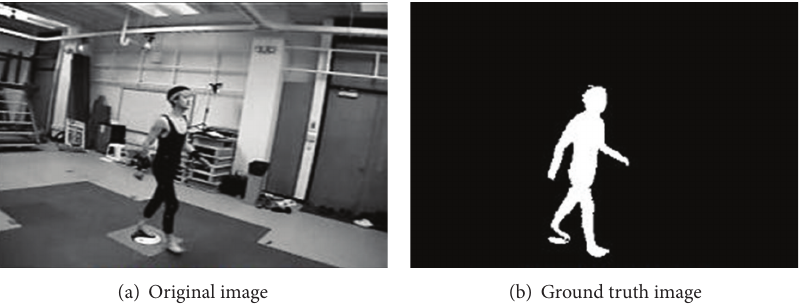
Figure 4: Original image and its ground truth of a frame in B1 for an indoor environment.